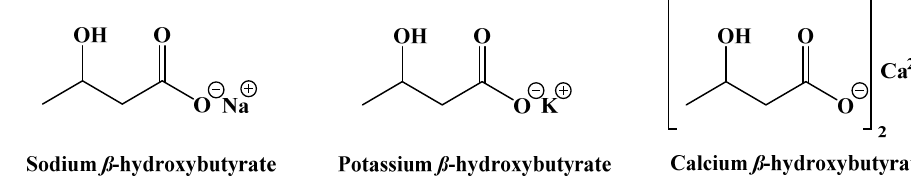
Figure 18. β -Hydroxybutyrate Mineral Salts.